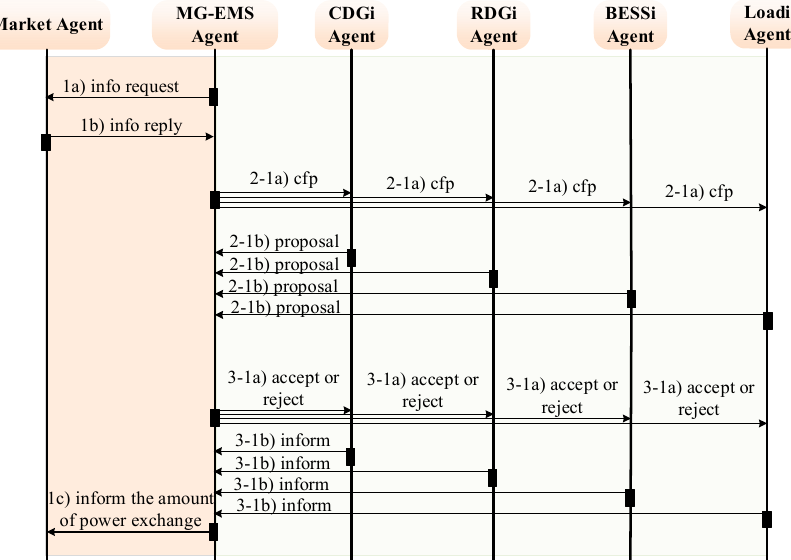
Figure 4. Agents communication in normal operation.